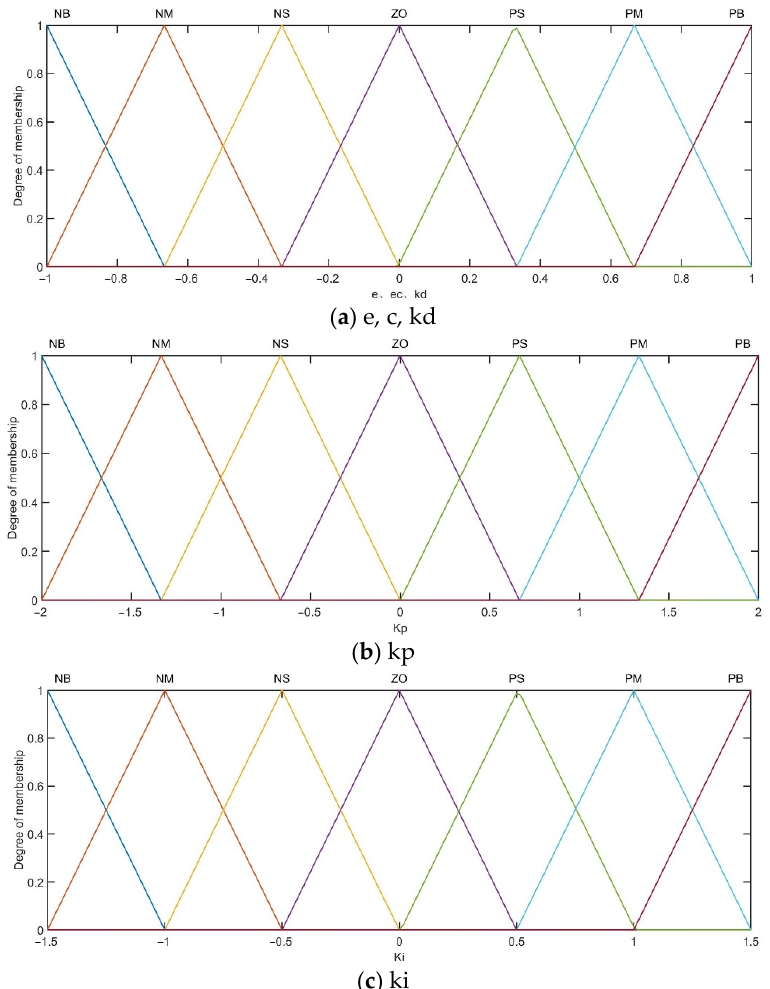
Figure 3. Degree of membership graph. (a) Membership function graph of e, ec and kd. (b) Membership function graph of kp. (c) Membership function graph of ki.